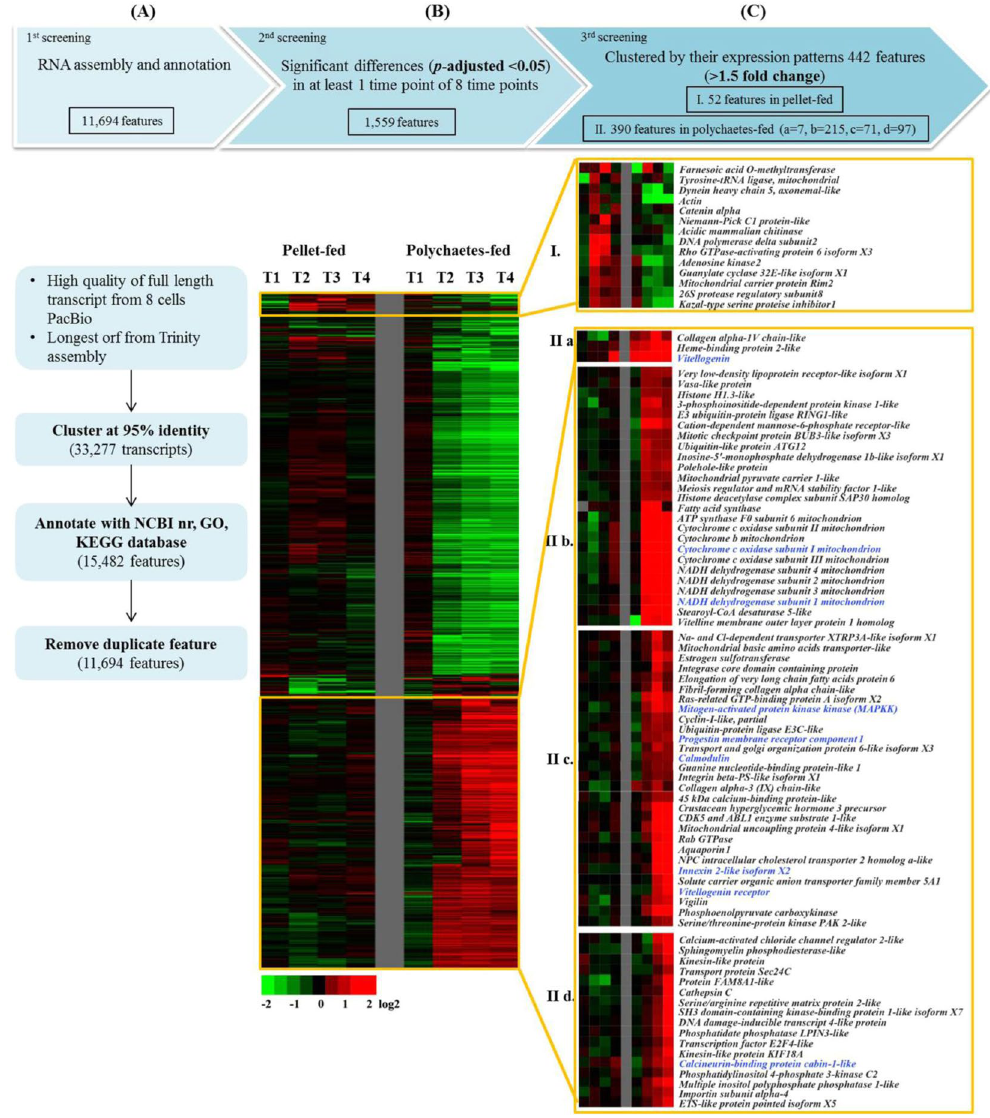
Figure 4. Gene expression analysis by RNA sequencing. Transcript levels in ovaries after a 4-week feeding trial (T1) were compared to before the trial (T0). Transcript levels in ovaries after eyestalk ablation at Day 1, 4 and 9 (T2, T3, and T4, respectively) were compared to those from non-ablated broodstock (T1). ( A ) A total of non-redundant and annotated 11,694 features were obtained from RNA sequencing. ( B ) Hierarchical clustering analysis of the 1,559 features with significant differences (p-adjusted < 0.05) in at least 1 time point of 8 time points. ( C ) Genes that exhibited changes in their expression level > 1.5 folds (442 features) were clustered into Cluster I–II exhibiting various differentially expressed patterns as effects of diets and eyestalk ablation: Upregulation in pellet-fed group (I), Upregulation in polychaete-fed group (II) with cluster IIa contains genes with upregulation before (T1) and after (T2-T4) the ablation, cluster IIb contains genes with upregulation after the ablation (T2, Day 1) until T4 (Day 9), cluster IIc contains genes with upregulation at T3 (Day 4) after the ablation, and cluster IId contains genes with upregulation at T4 (Day 9) after the ablation. Transcripts in blue letters were further characterized by quantitative real-time PCR (Supplementary Fig.